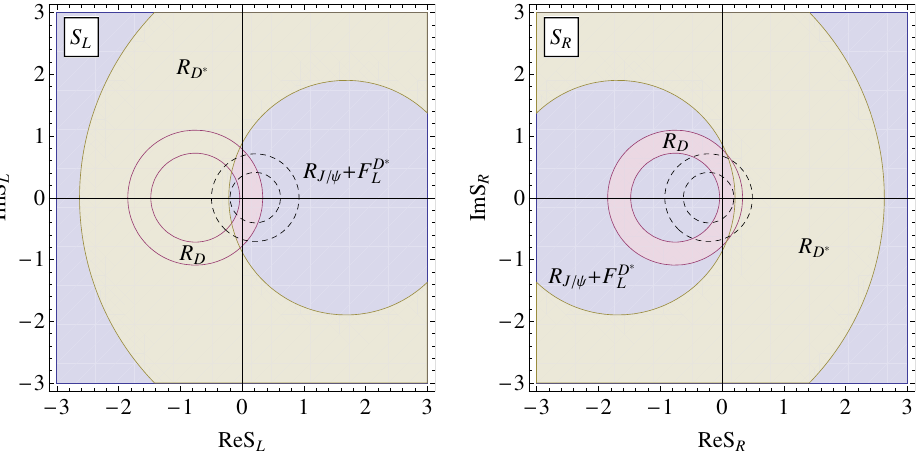
Figure 3. Constraints on the complex Wilson coefficients S L ( left ) and S R ( right ) from the measurements ( B → D ∗ τν τ ) within 2 σ , and from the branching fraction B ( B c → τν τ ) . of R D , R D ∗ , R J / ψ , and F D ∗ L The small (large) dash curve represents the constraint B ( B c → τν τ ) ≤ 10% ( B ( B c → τν τ ) ≤